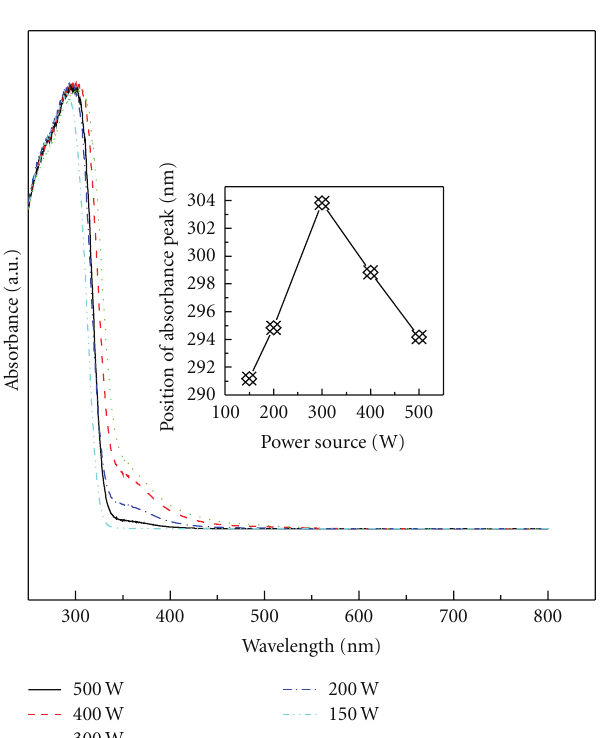
Figure 3: Optical absorption spectra of 2-ethylhexanoic acid- coated ZnS:Mn 2+ nanoparticles prepared using di ff erent micro- wave power. Inset shows variation of absorption peak positions for the samples synthesized using di ff erent microwave